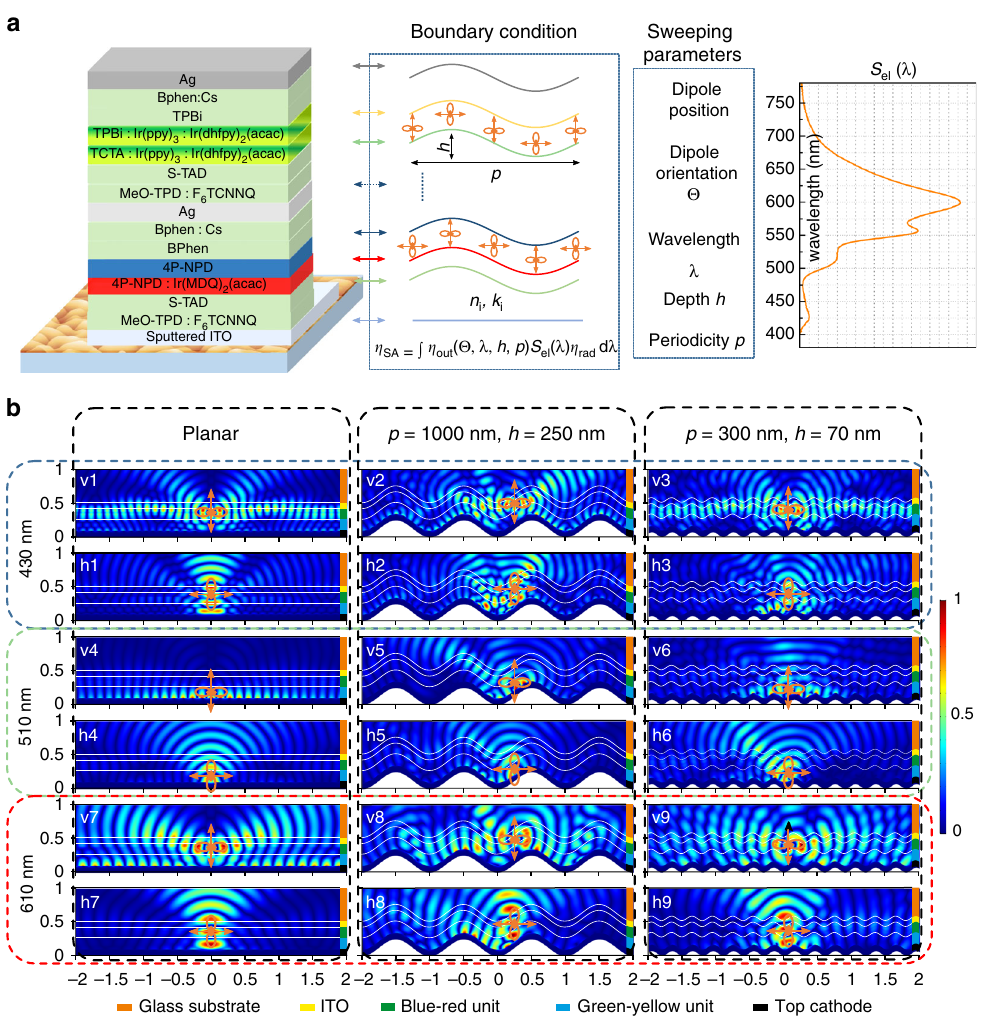
Fig. 4 Schematic diagrams of the proposed optical modeling. a The device architecture and schematic illustration of the simulation model. The outcoupling ef fi ciency η out is dependent on the dipole orientation Θ and the position on the sinusoidal interface, emitting wavelength λ , periodicity p , and depth h of the sinusoidal nanostructures. b Normalized steady state electric fi eld for vertical and horizontal dipoles. At wavelengths 430 nm for vertical dipoles (v1 – v3) and horizontal dipoles (h1 – h3), 510 nm for vertical dipoles (v4 – v6), and horizontal dipoles (h4 – h6), 610 nm for vertical dipoles (v7 – v9) and horizontal dipoles (h7 – h9). Three different con fi gurations are presented – fl at ( fi rst column), nanostructured devices with P = 1000 nm, h = 250 nm (second column) and P = 300 nm, h = 70 nm (third column). Dipoles are located in the middle - between minima and maxima of the sine texture inside corresponding emission layers. All dimensions are in μ